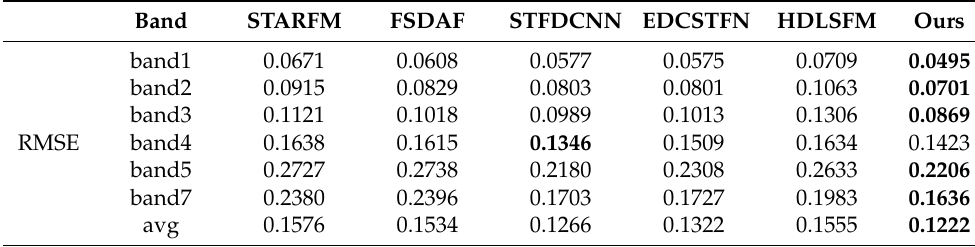
Figure 12. The fusion results on 12 December 2001 in LGC (the first row exhibits the false color composite images using band 4, band 3, and band 2; the second row exhibits the zoomed-in details of the yellow rectangles marked in the first row; the third row exhibits the average difference map between the prediction and ground truth; the fourth row exhibits the average surface reflection change map). Table 1. Evaluation metrics of LGC prediction results. Bold values indicate the best